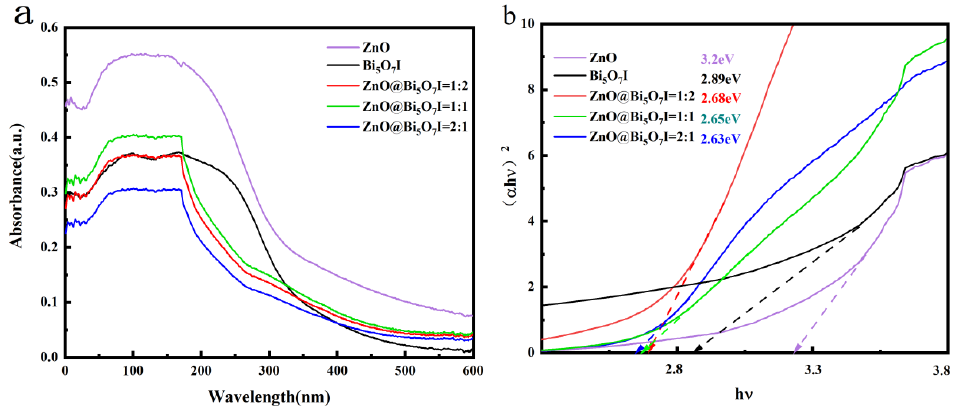
Figure 4. ( a ) UV-Vis diffuse reflectance spectrum and ( b ) band gap distribution of ZnO and Bi 5 O 7 I composite material magnification.